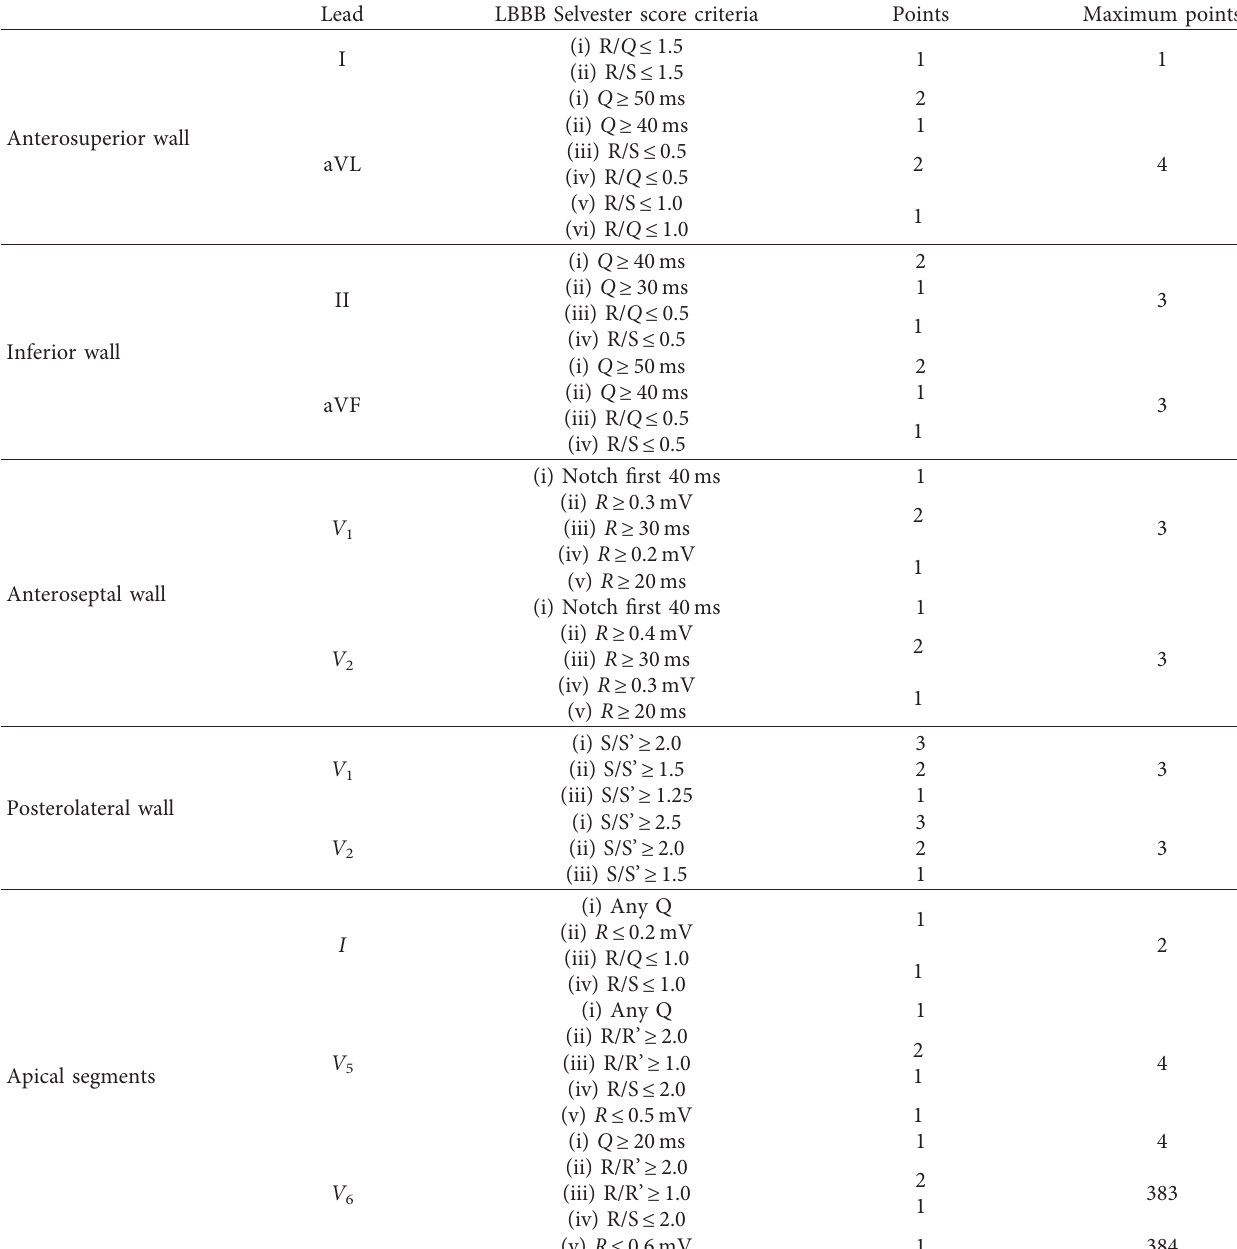
Table 1: LBBB Selvester score